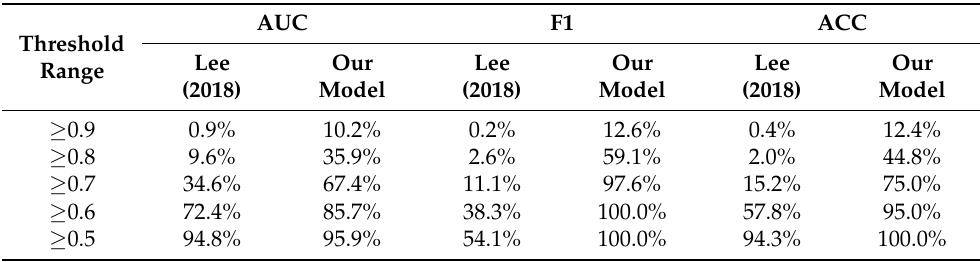
Table 3. Percentage of diseases meeting the indicated performance range for the proposed method and Lee’s method.